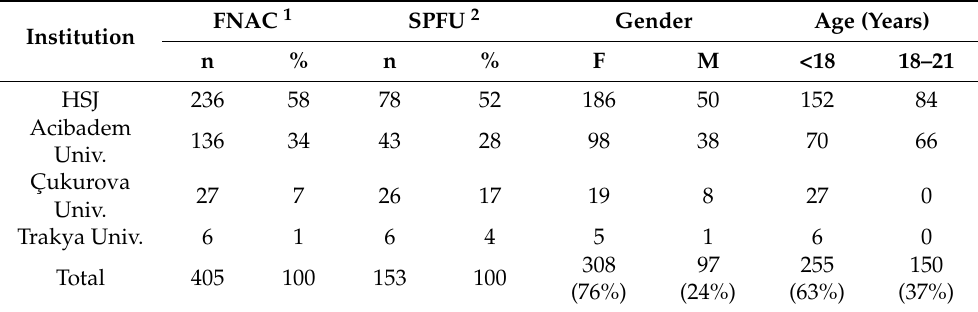
Table 1. Demographic data of the cases from each